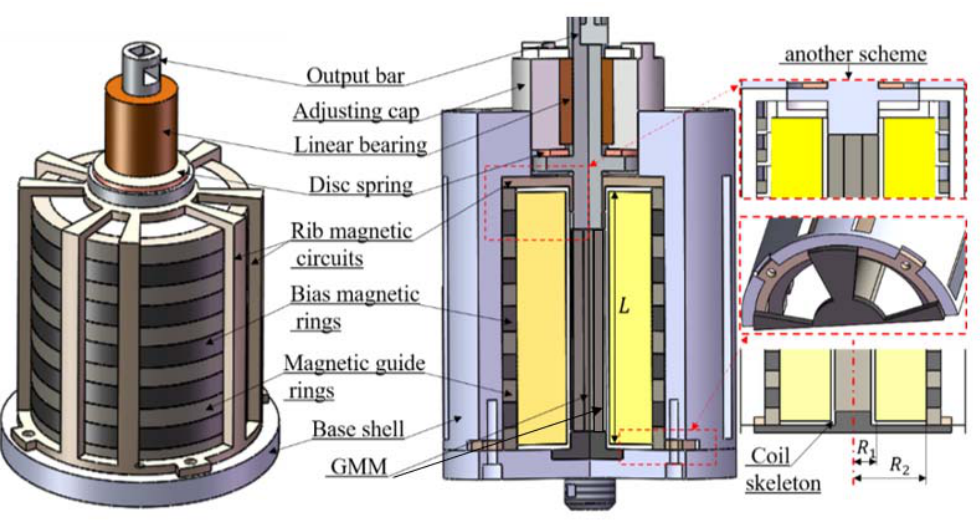
Figure 1. Schematic of the GMT.